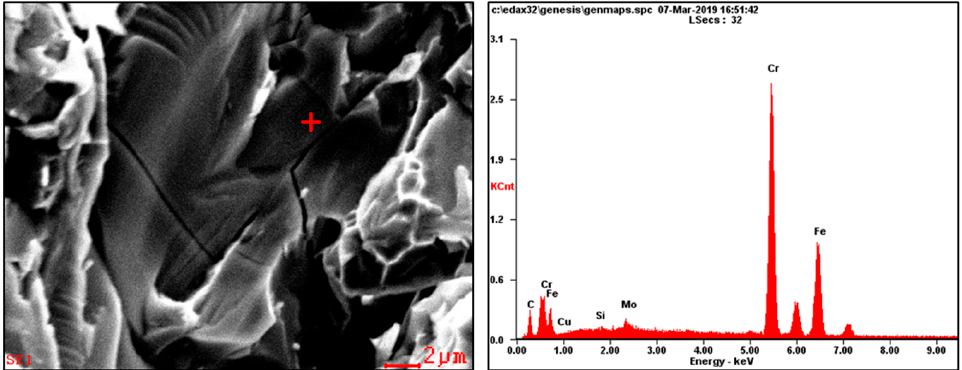
Figure 9. EDS result of the cracked zone in specimen #4.